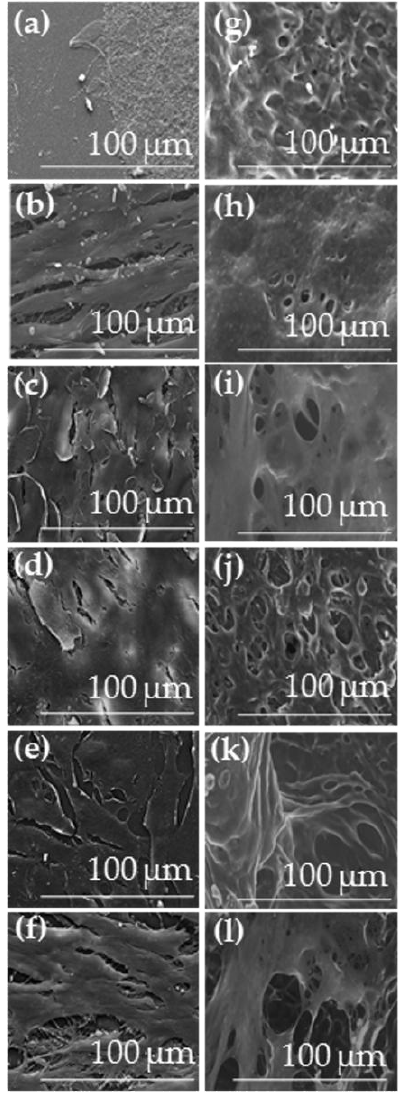
Figure 7. Morphology of cells on IPN hydrogel surfaces after organotypic culture. ESEM images (×1000) of the cells across six different organs/tissues: ( a , g ) brain; ( b , h ) intestine; ( c , i ) skin; ( d , j ) blood vessels; ( e , k ) cornea; and ( f , l ) gonads; cultivated on ( a – f ) Thermanox ® and ( g – l ) PEO(5%)coHSAm(5%)fb(0.5%) IPNs. Confocal laser scanning microscopy (CLSM) images